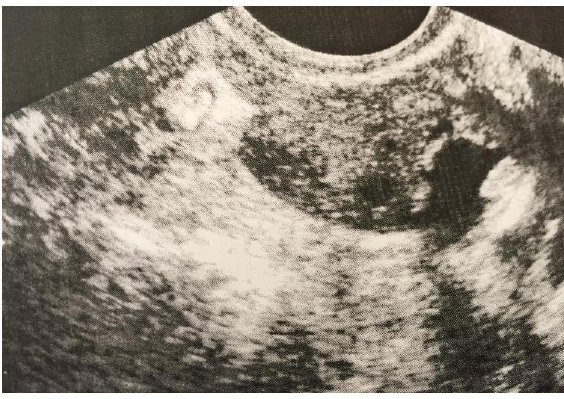
Figure 3: Free fluid in cul-de-sac after